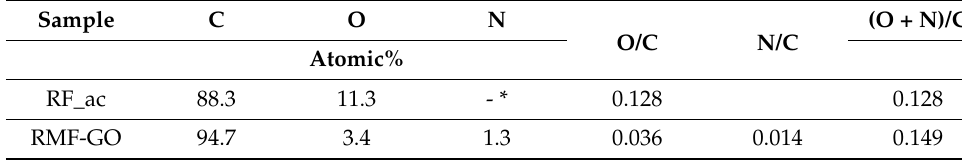
Table 3. Surface composition of the pristine samples from XPS.